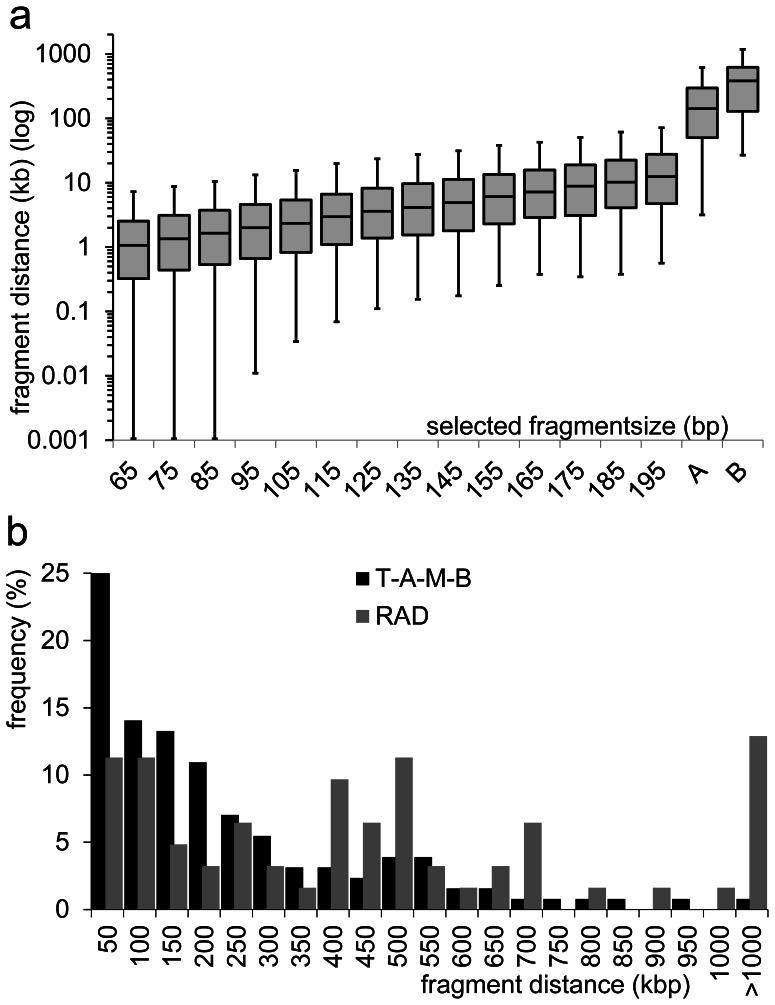
Distances of RESTseq fragments.(a) Illustration of interfragment distances in relation to the selected fragment size (range of 20 bp) and thus numbers of the fragments (cf. Fig. 1b). The Box-Whiskers-Plot shows the median with 25th–75th percentile and 5–95% as errorbars. For comparative reasons we further included (A) 129 fragments obtained from a TaqI library which was reduced by MseI, ApoI and BstUI and selected for 190–200 bp and (B) 124 fragments obtained from 62 SbfI recognition sites on A. mellifera LG1. (b) Frequencies of distances between 129 fragments obtained from a TaqI library which was reduced by MseI, ApoI and BstUI (T-A-M-B) and selected for 190–200 bp and 124 fragments obtained from 62 SbfI recognition sites (RAD) on A. mellifera LG1.